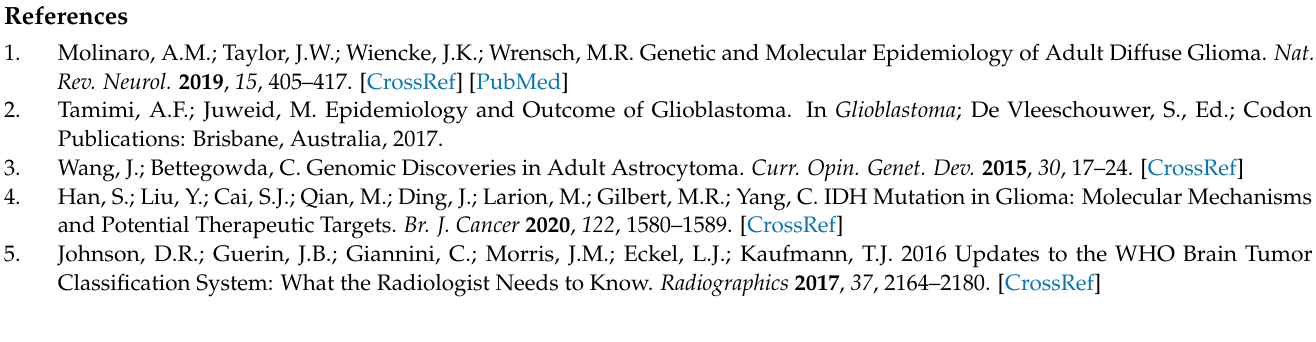
loss curves, Table S1: Demographic and molecular data for training and testing cohorts with rCBV sequence, Table S2: Demographic and molecular data for training and testing cohorts with T1 and T2 sequences, Table S3: Demographic and molecular data for training and testing cohorts with ADC sequence, Table S4: Demographic and molecular data for training and testing cohorts with FLAIR sequence, Table S5: Demographic and molecular data for training and testing cohorts with MPRAGE